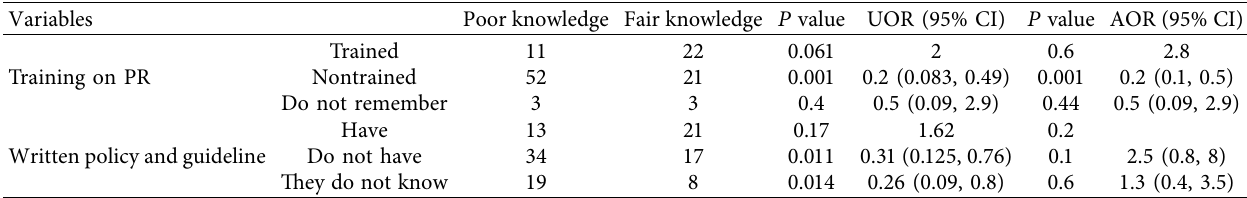
Table 7: Factors associated with nurses’ knowledge regarding physical restraint use in bivariate and multivariate analysis ( n � 112). Variables